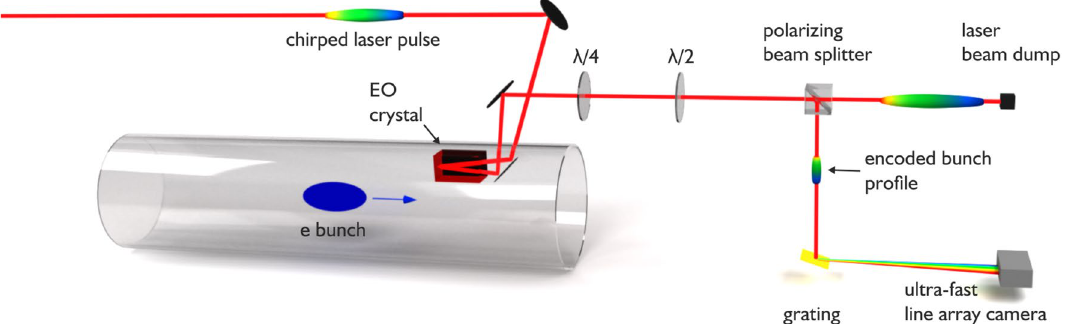
Figure 1. The setup to measure charge density profiles of electron bunches in a storage ring with single-shot electro-optical sampling of the near-field is shown (see 37–39 ). The closed metallic beam pipe of the accelerator is here indicated as a transparent